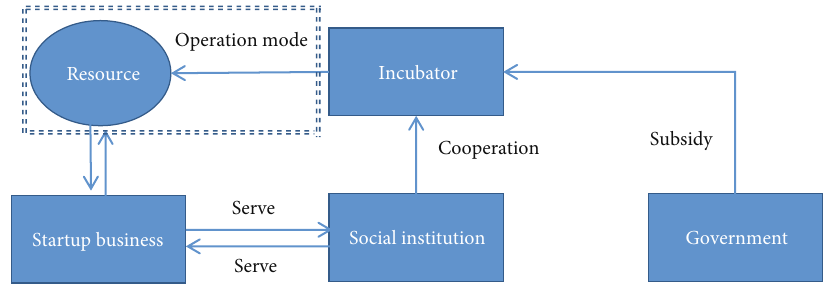
Figure 1: Incubator business logic